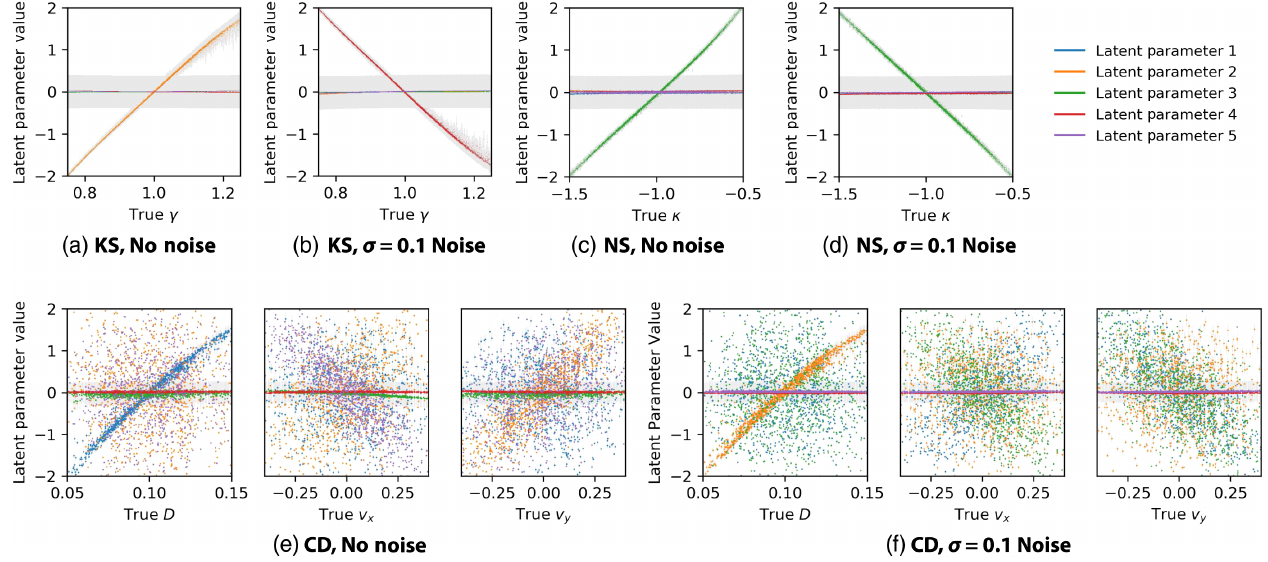
FIG. 7. The five latent parameters in the models trained on the (a),(b) 1D Kuramoto – Sivashinsky, (c),(d) 1D nonlinear Schrödinger, and (e),(f) 2D convection – diffusion datasets both with and without added noise versus the ground truth physical parameters used to generate the datasets. In these plots of the raw extracted latent parameters, we see the direct correspondence between the identified relevant latent parameters in Fig. 2 and the true physical parameters as well as the collapse of the unused latent parameters. Note that the relevant latent parameters corresponding to the drift velocity v in the convection-diffusion model are not precisely aligned with the two components v , v due to the inherent rotational symmetry. The gray shaded bars are the 95% confidence intervals ( (cid:3) 1 . 96 σ x y by the